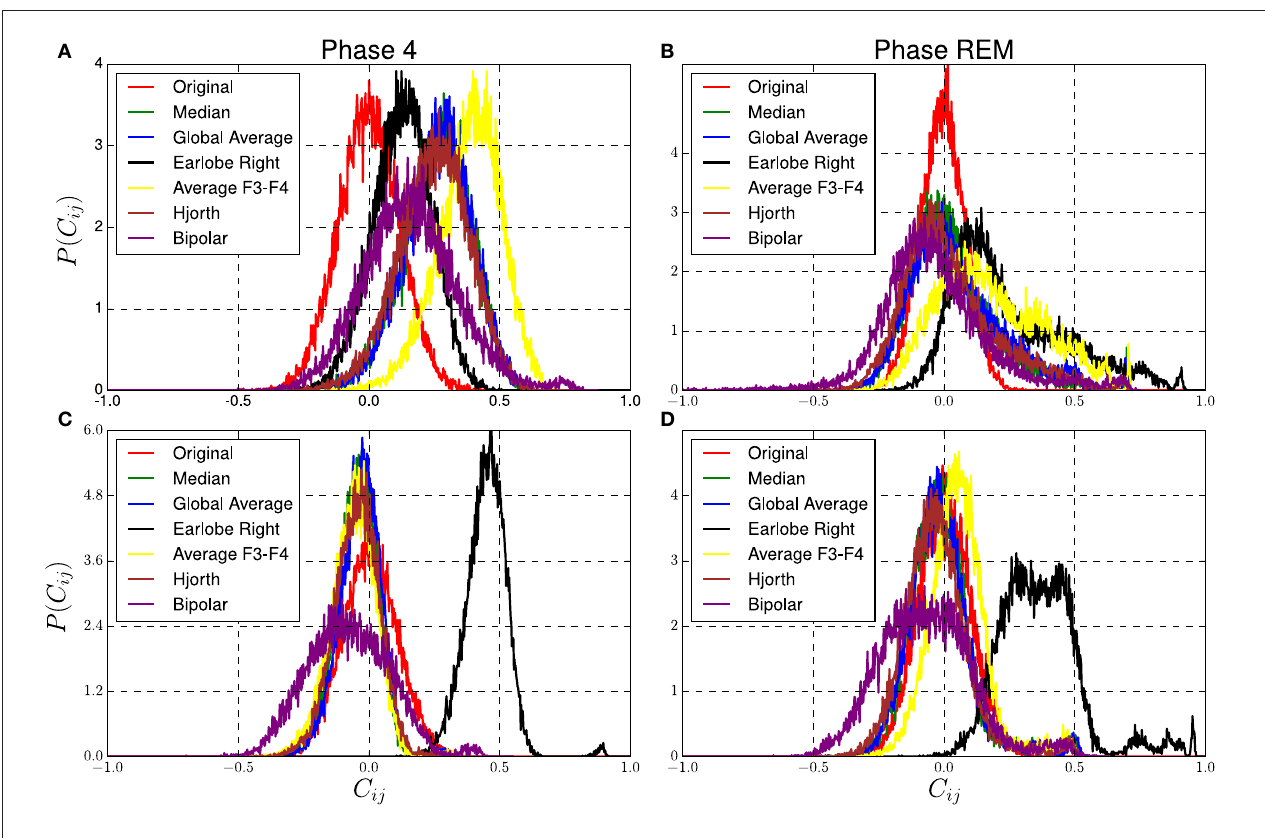
FIGURE 8 | Distribution of non-diagonal elements of correlation matrices estimated from reference transformed data derived from model 1 of Table 1 . Reference signals are extracted from real EEG-recordings of a healthy subject during sleep stage 4 (A,C) and REM sleep (B,D) , for the δ as described in the main